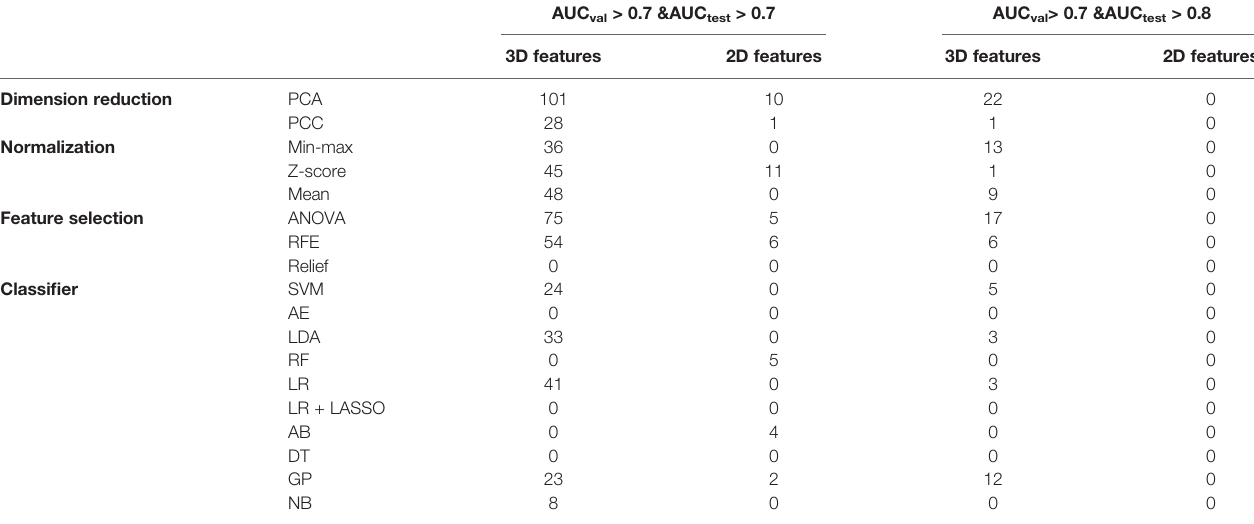
TABLE 2 | The number of models with AUC greater than 0.7 in both validation and test groups.